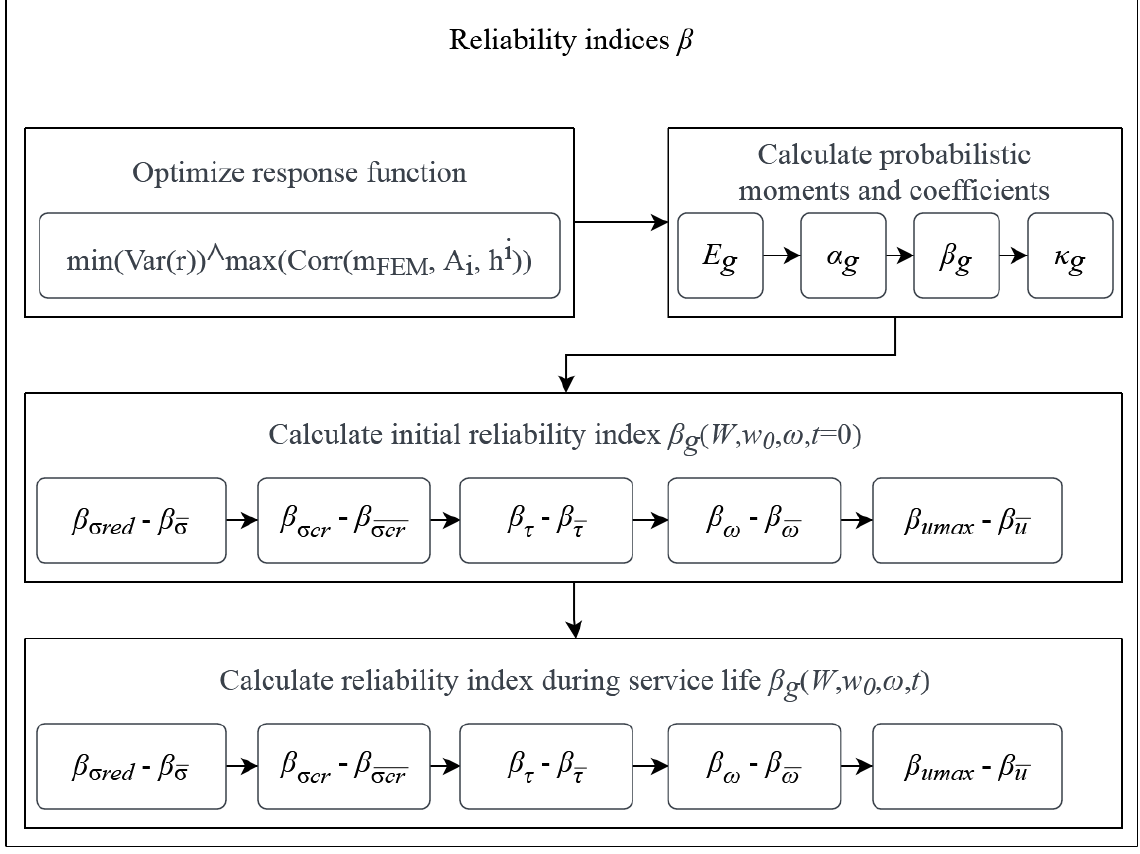
Figure 3. Procedure for the determination of reliability indices.